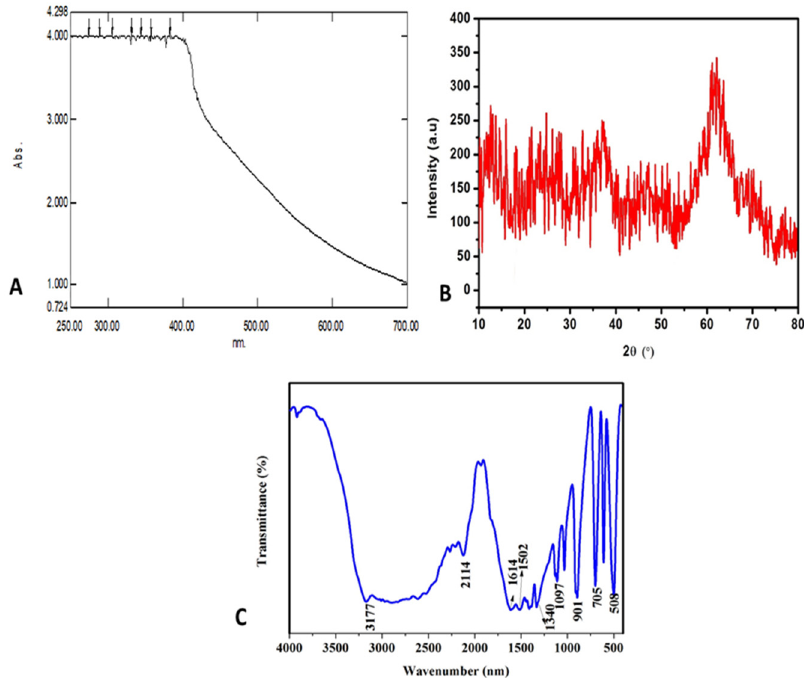
Figure 1. ( A ) Ultraviolet-visible spectra recorded, ( B ) XRD recorded and ( C ) FT-IR recorded of selenium nanoparticles synthesized using D. indica leaf broth.